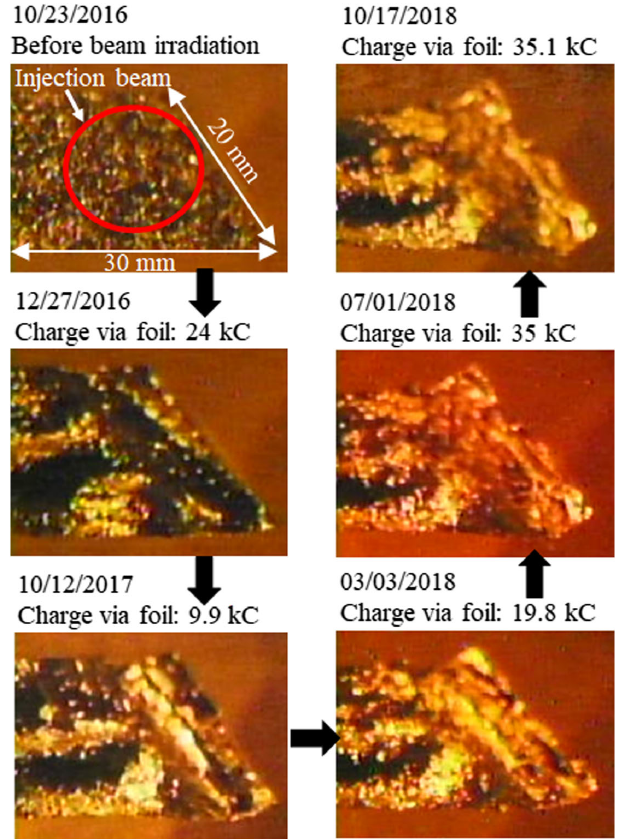
13. Photographs of the stripper foil taken during beam irradiation. A qualitative progression of the foil degradation was observed as accumulated charge was increased. The foil started to deform around the injection beam center first, then the curling was quite visible after one year operation, and it grew faster at the end of 2 yr